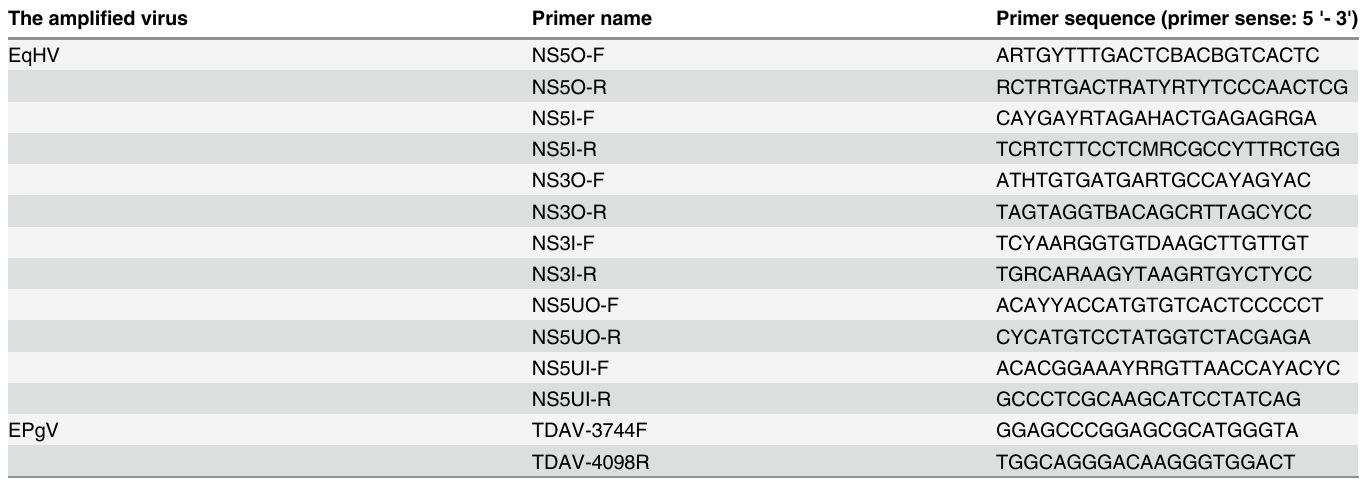
Table 2. The primer sequences for EqHV and EPgV in our